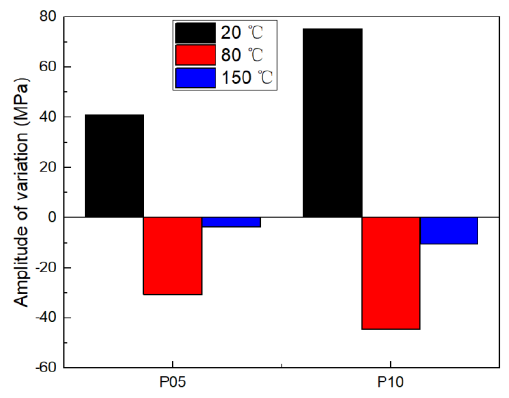
Figure 11. Amplitude of variation of peak stress compared with P0.